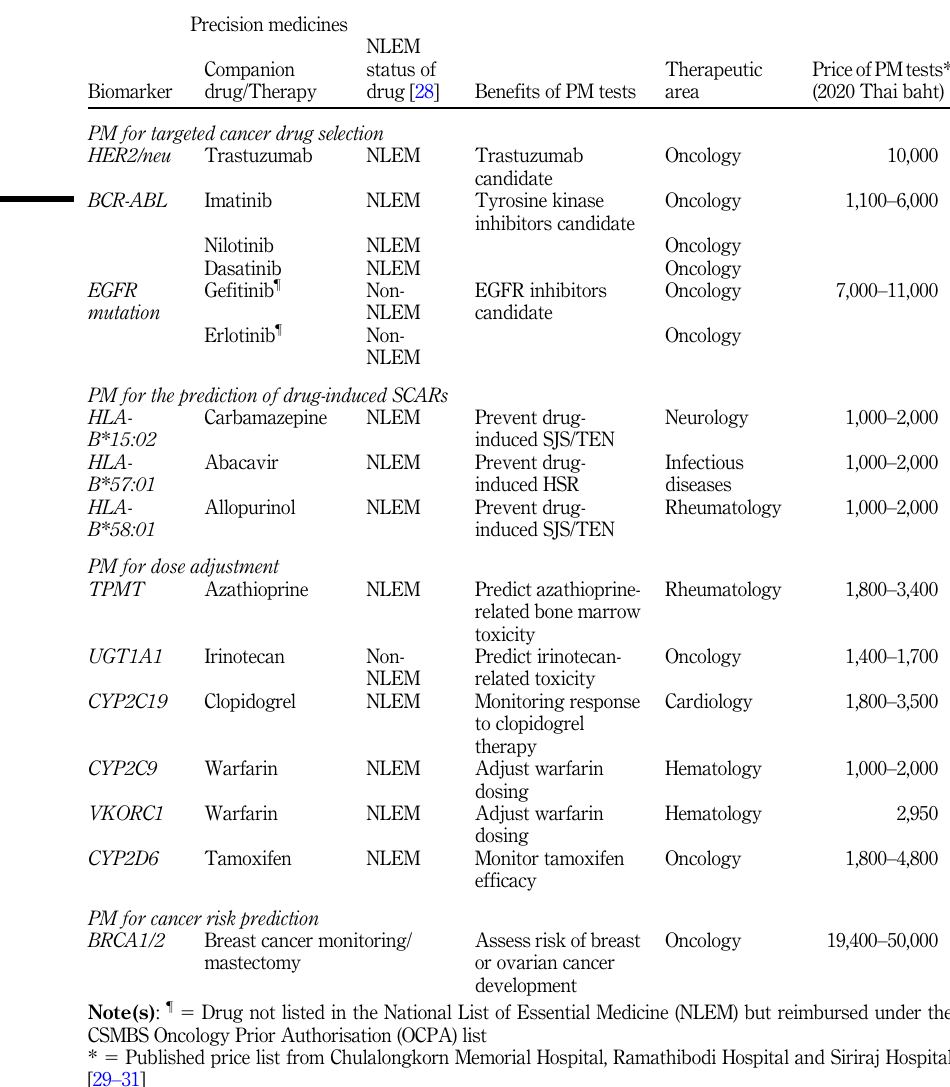
Table 1. Characteristics of 13 studied precision